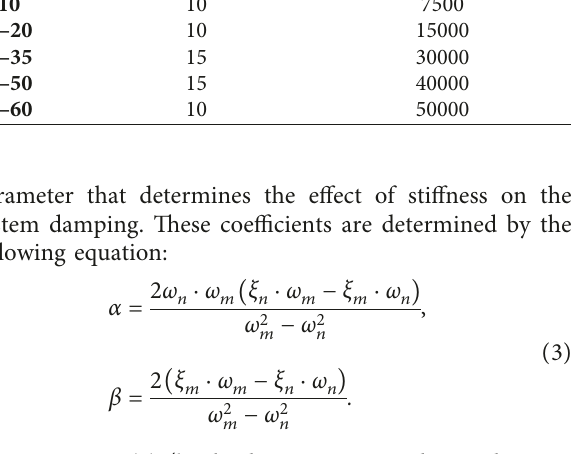
Table 2: The models studied in the present research. Elasticity module of soil Lining Overburden No. (compared to Delhi thickness depth (m) Metro)